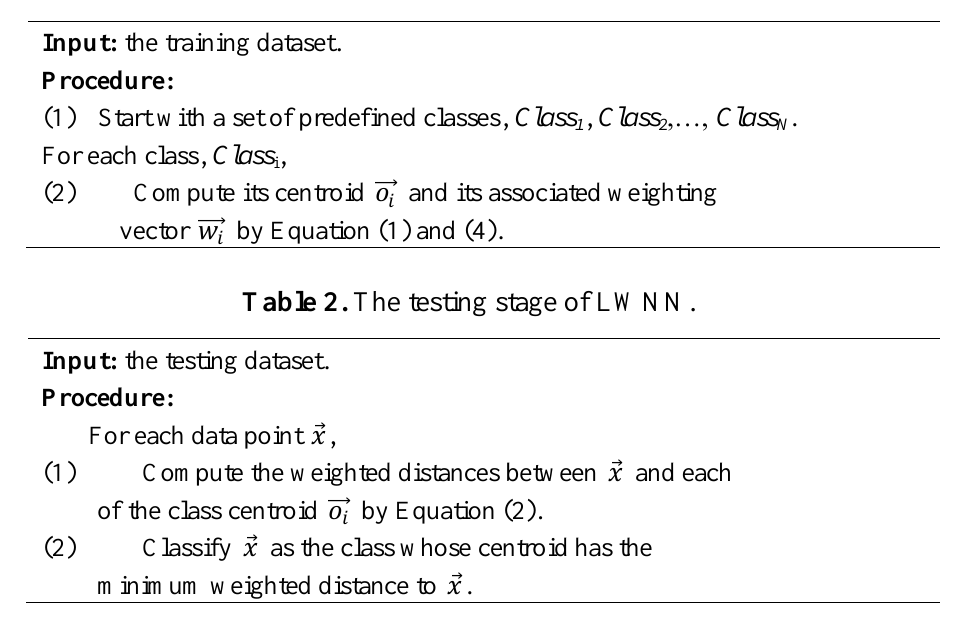
Table 1. The training stage of LWNN.